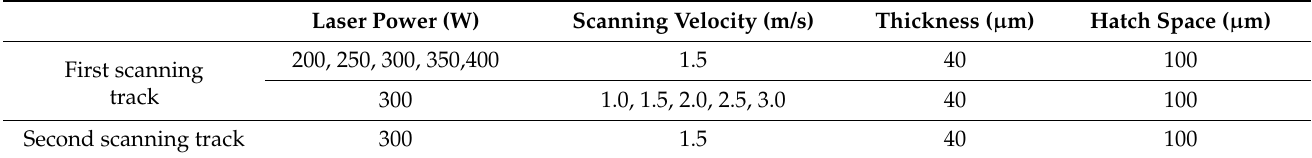
Table 3. Process parameters of L-PBF process.